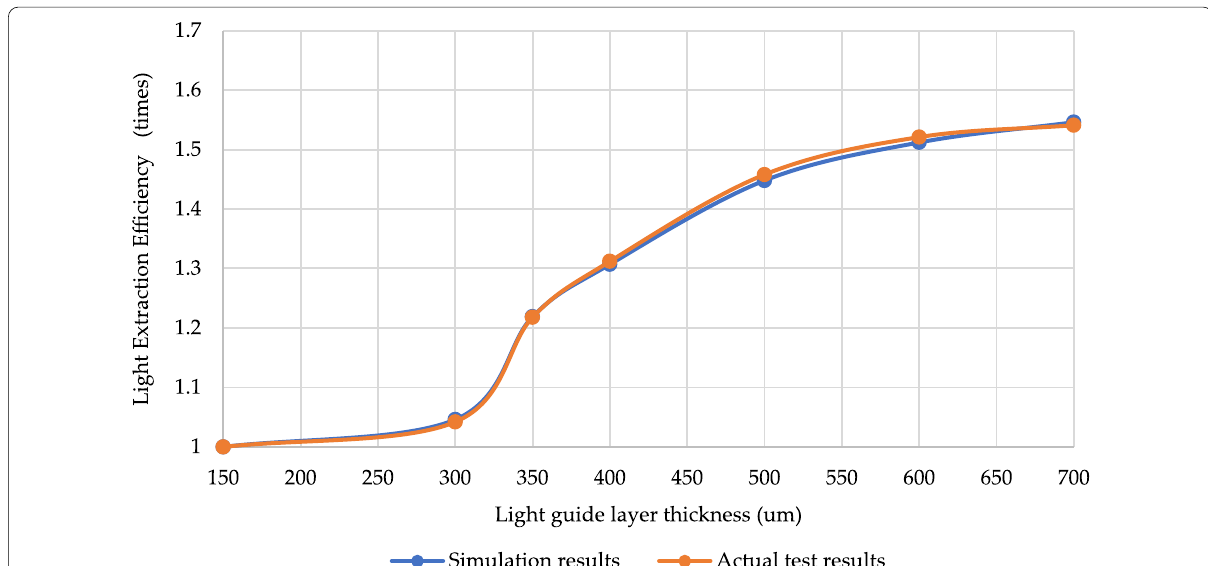
Fig. 7 Compared simulated and measured LEE enhance times of UV‑C LEDs with a light guide layer thickness of 150–700 um